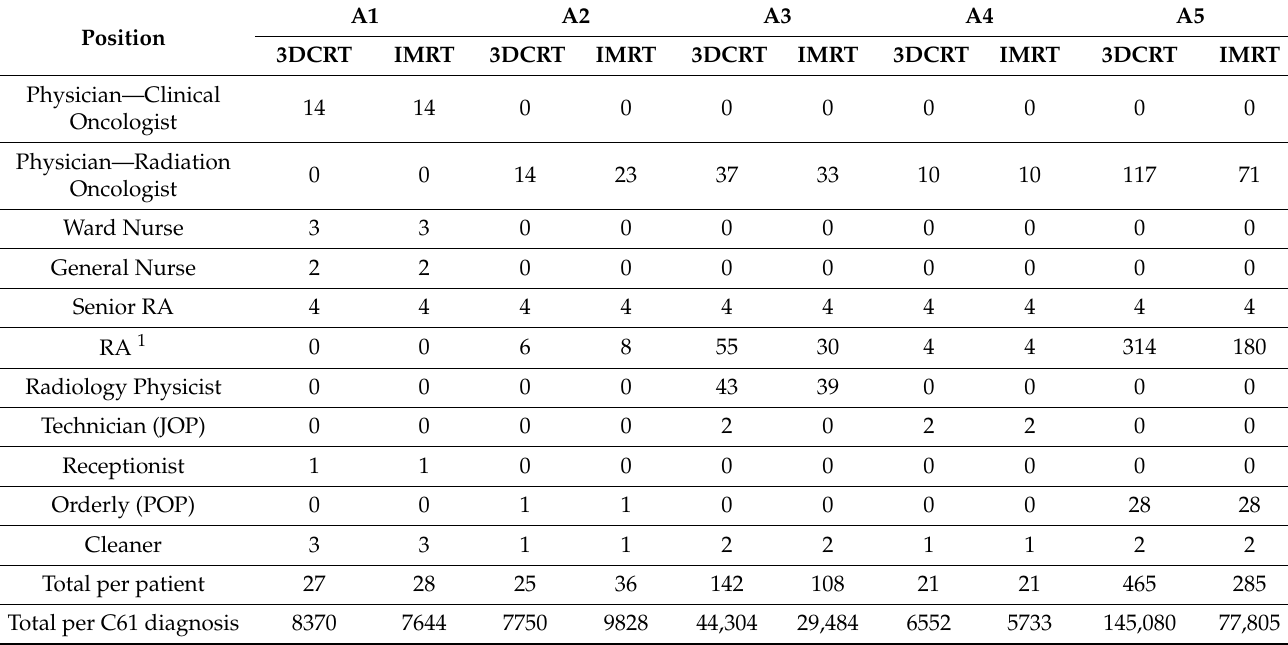
Table 9. Labor costs matrix